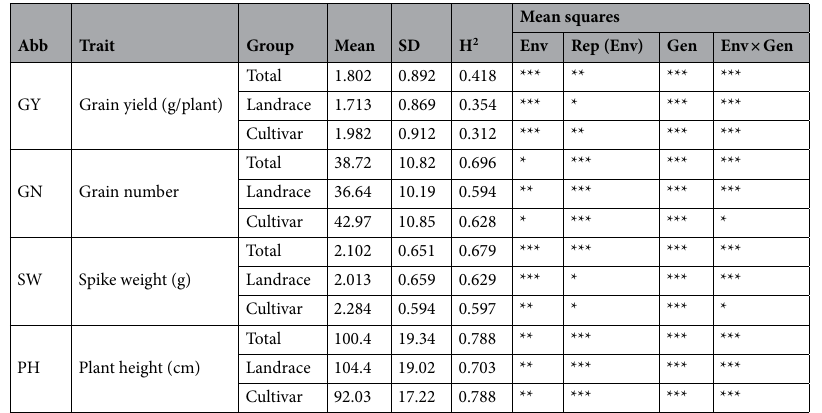
Table 1. Mean, standard deviation (SD), broad sense heritability (H 2 ), and combined analysis of variance based on studied traits in 286 Iranian wheat landraces and cultivars and 6 environments. *, ** and *** are significant at the probability level of 5%, 1% and 0.1%,